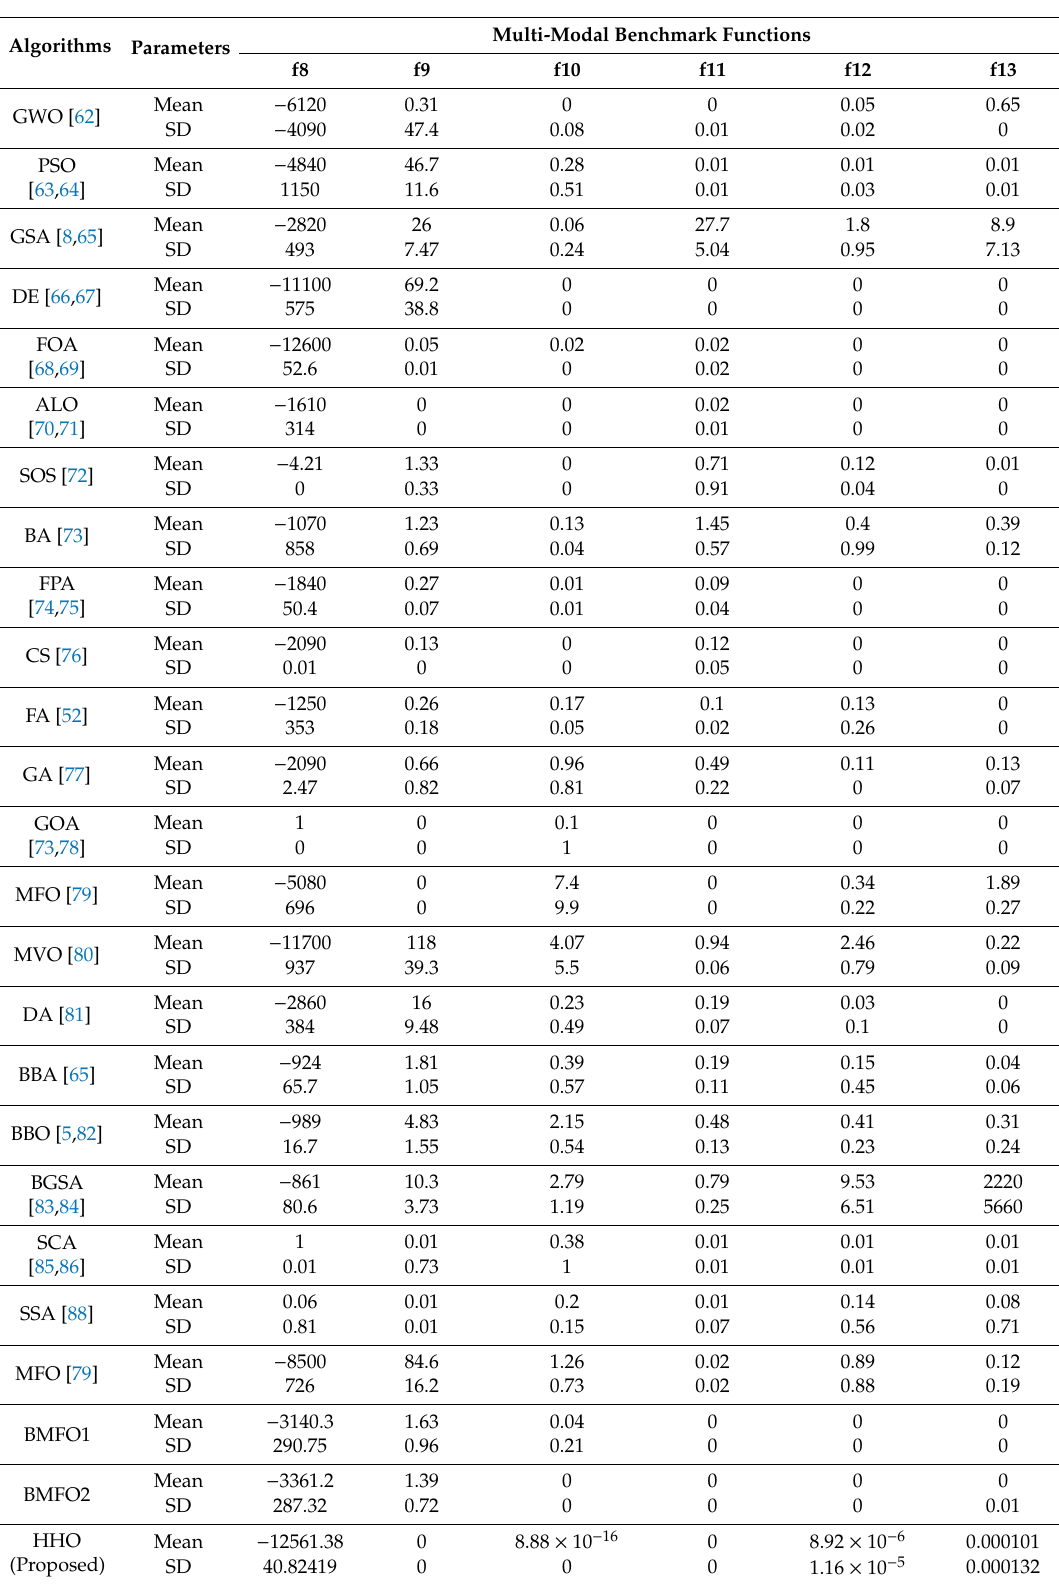
Table 7. Comparison of multi-modal benchmark